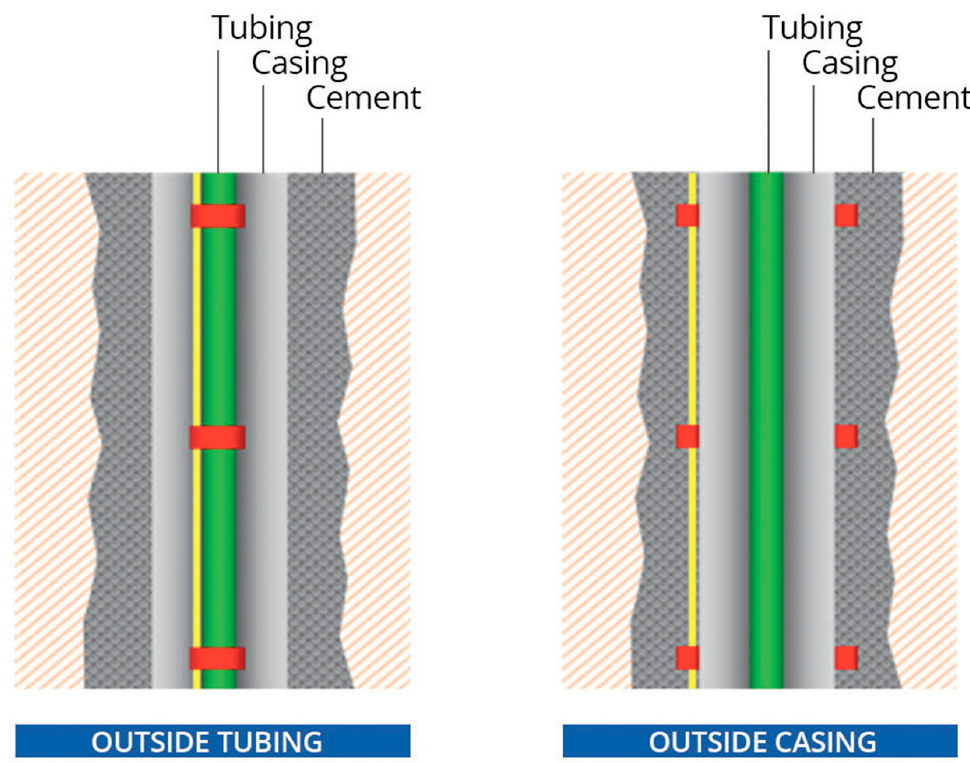
Figure 1. Different types of DAS installation. Elements of the well are marked, and the fiber is in yellow. Figure from Naldrett et al. (2020), First Break.